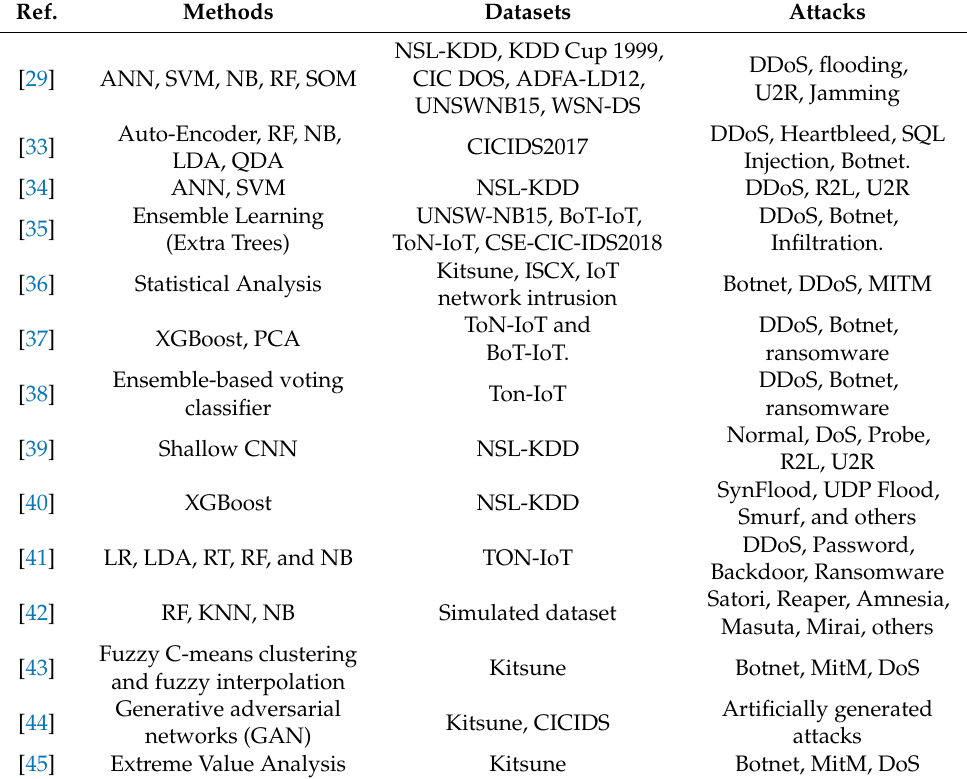
Table 2. Comparison among some state-of-the-art NIDS solutions. ANN stands for Artificial Neural Networks, NB for Naïve Bayes, RF for Random Forests, SOM for Self-Organizing Maps, LDA for Linear Discriminant Analysis, QDA for Quadratic Discriminant Analysis, PCA for Principal Component Analysis, RT for Regression Trees, LR for Logistic Regression, U2R for User to Root, R2L for Remote to